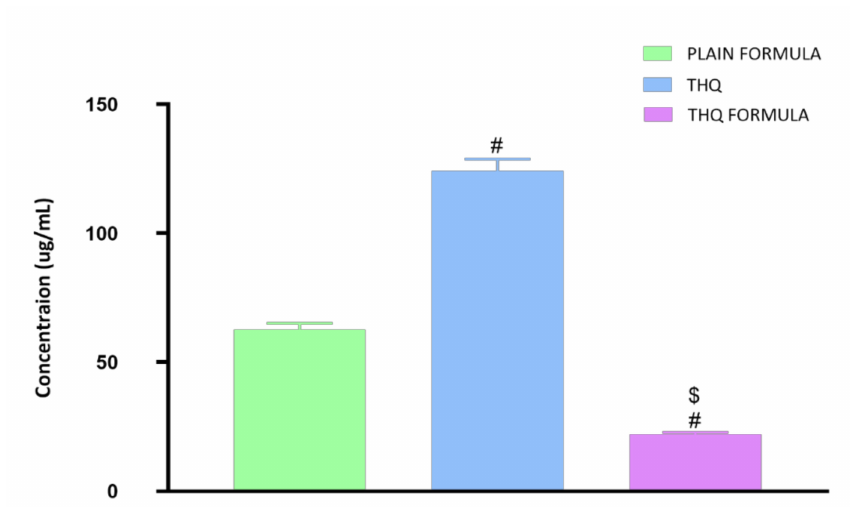
Figure 4. Representation of the IC50 values of plain formula, THQ, and THQ formula in A549 cells. # Significantly different from plain formula at p < 0.05. $ Significantly different from THQ at p <